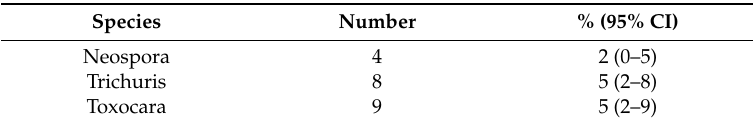
Figure 2. Percentage of dogs with fecal parasites decreased with age for Toxocara canis ( left ; p ≤ 0.0001) and Giardia ( right ; p ≤ 0.0001). Data from a cross-sectional survey of working dogs’ health conducted in the central North Island of New Zealand in 2010, which included 57 working farm dog owners and 202 working dogs. Note: Age was missing for four dogs owned by two different people and fecal samples were missing for 31 dogs owned by 19 different people. However, only one owner provided no fecal samples for any dog in their team. Table 4. Number and percentage of dogs, with 95% confidence interval (95% CI), with fecal parasite by species of parasite. Data from a cross-sectional survey of working dog health conducted in the central North Island of New Zealand in 2010 in which fecal samples were collected from 171 dogs owned by 56 different people.